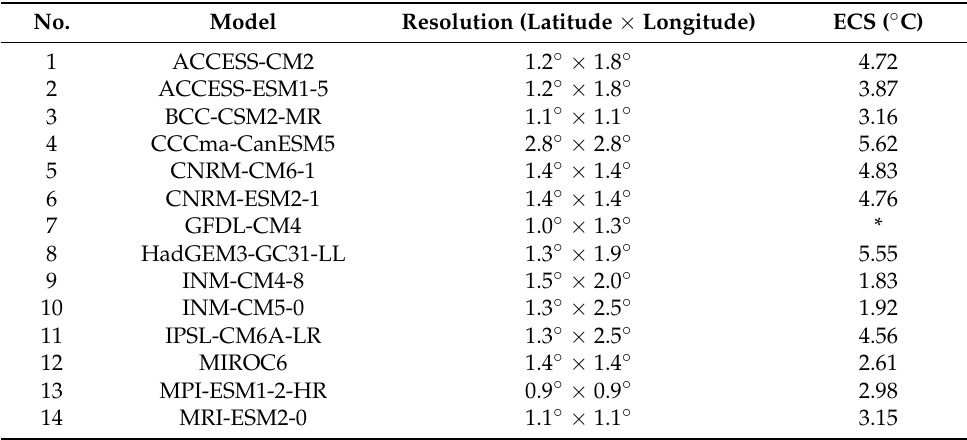
Table 1. Model name, resolution, and ECS of 14 CMIP6 GCMs.